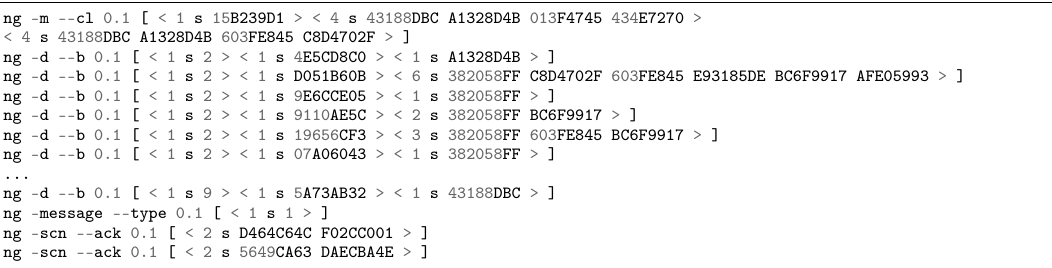
Figure 12. Log of APS exposition to enable RMS discovery of this access point proxy/control service.